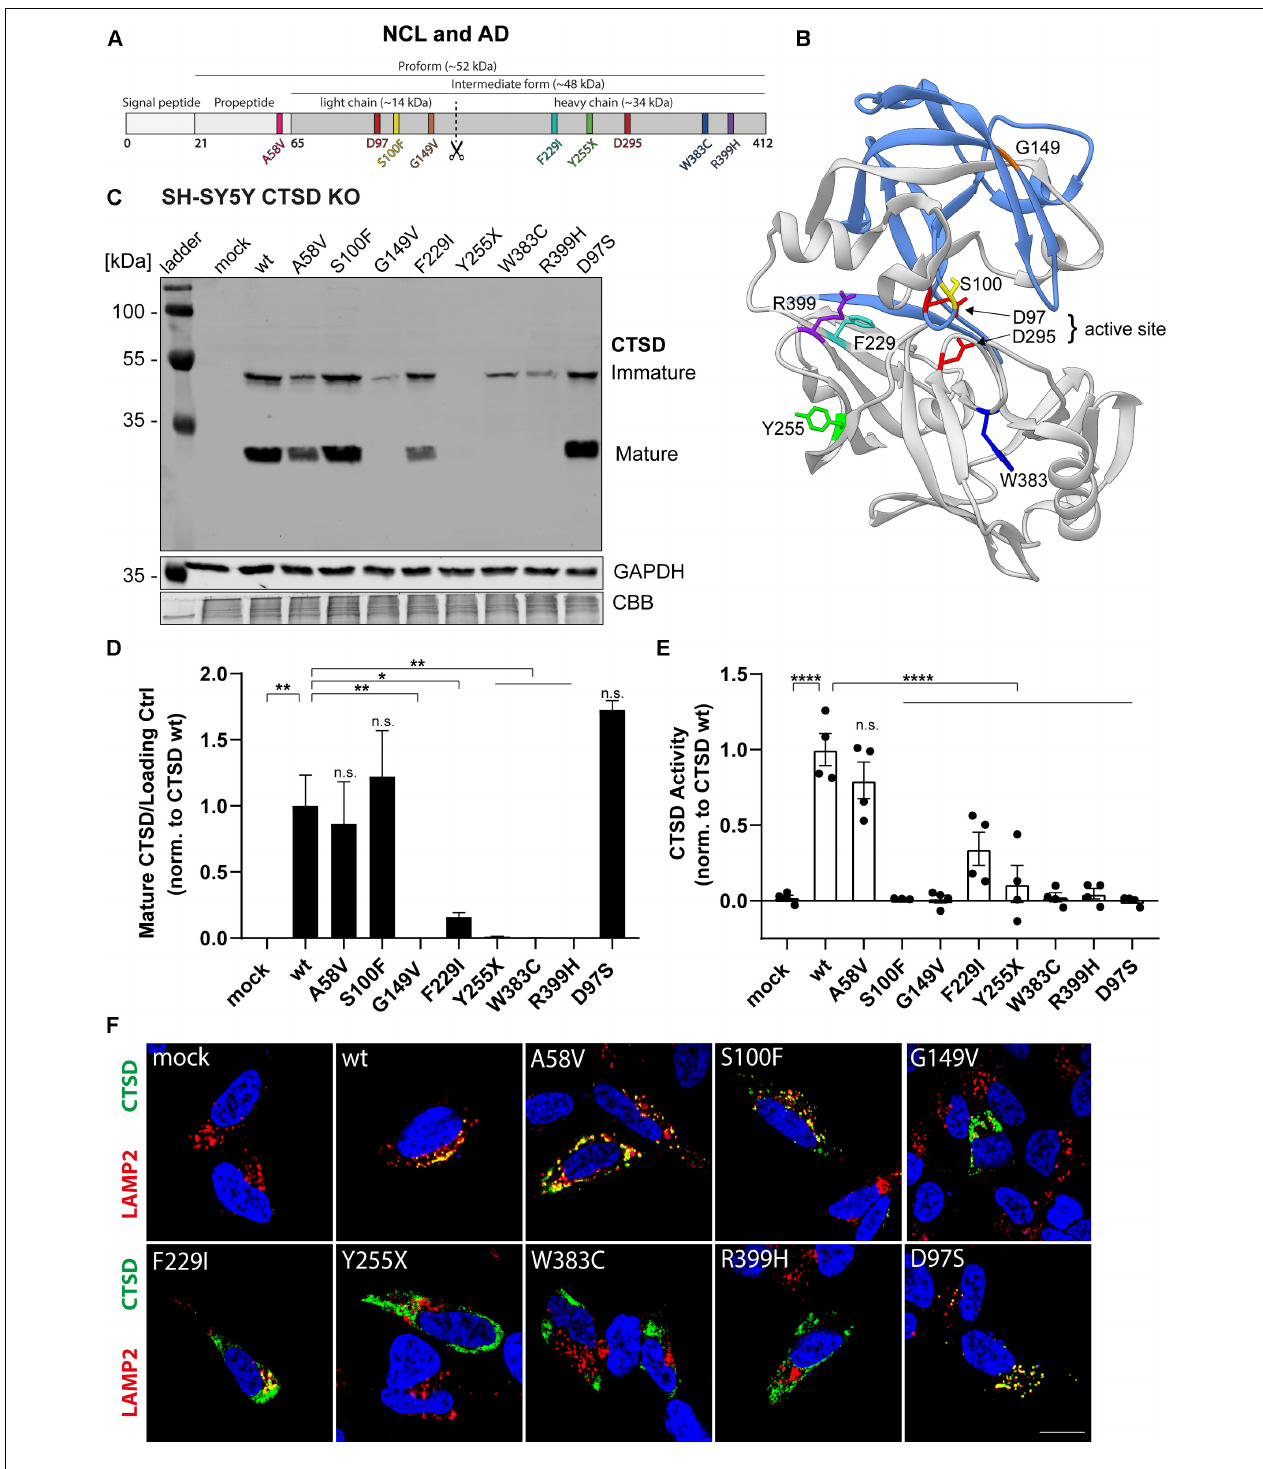
FIGURE 1 | Characterization of CTSD variants associated with neurodegenerative diseases in SH-SY5Y CTSD KO cells. (A) Schematic overview of NCL- and AD-associated CTSD variants analyzed in this study. During protein maturation, the signal peptide (20 aa) and the propeptide (44 aa) are removed, generating an intermediate form ( ∼ 48 kDa) that is further processed in the lysosome into a double-chain mature form comprised of a light chain ( ∼ 14 kDa) and a heavy chain ( ∼ 34 kDa; symbolized by scissor symbol). Both chains remain associated by hydrophobic interactions. Point mutations found in NCL- and AD- patients located within different protein parts are shown in different colors (A58V, pink, propeptide; S100F, yellow, light chain; G149V, orange, light chain; F229I, light blue, heavy chain; Y255X, green, heavy chain; W383C, dark blue, heavy chain; R399H, purple, heavy chain). Aspartates D97 and D295 as part the catalytic site are